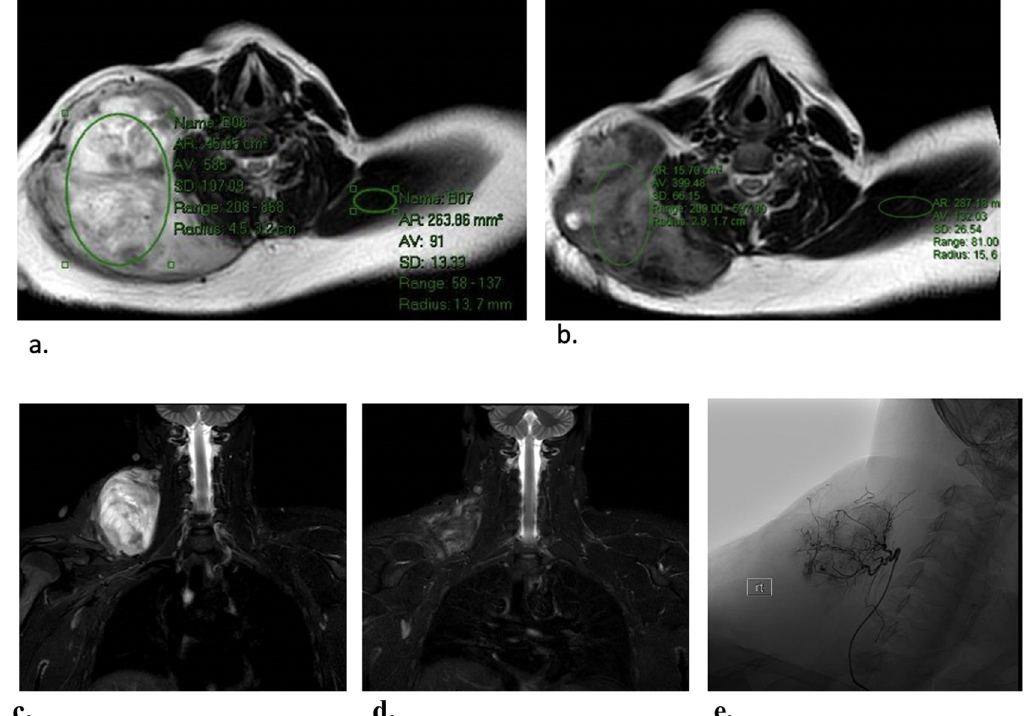
Figure 1. Representative images demonstrating T2 intensity reduction in a patient with a right base of neck tumor, after two DEE treatments. Semi-quantitative T2 intensity was determined by measuring the signal intensity within a representative area in the DFs relative to the signal of normal muscle on the same slice. The T2 intensity at baseline ( a ) was 585 and that in the contralateral trapezius muscle was 9.1 (i.e., intensity ratio of 6.4). The respective T2 intensities 2 months after two DEE treatments ( b ) were 399 and 132 (i.e., intensity ratio of 3.0). Thus, the overall reduction in T2 signal intensity was 47%. Corresponding coronal short tau inversion recovery (STIR) images from before ( c ) and after ( d ) therapy. The hypervascular tumor was supplied by a branch of the right ascending cervical artery ( e ).